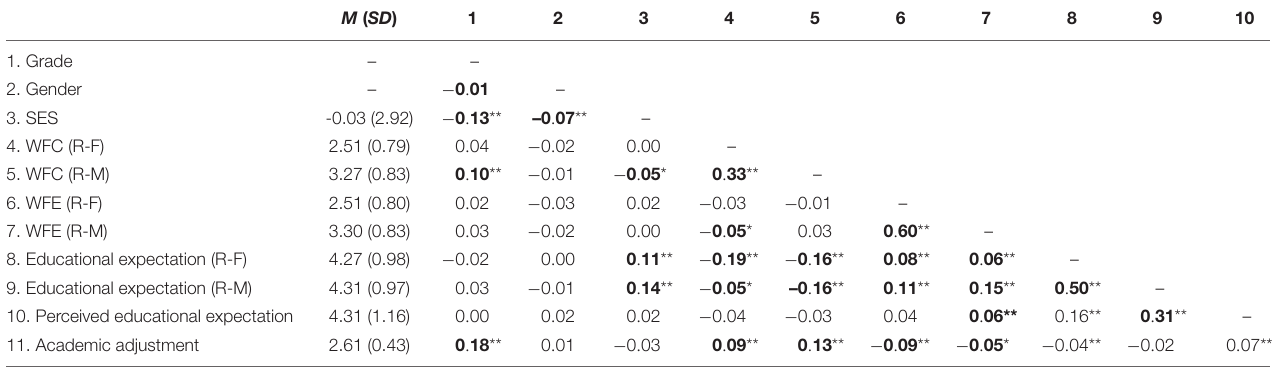
TABLE 1 | Means, standard deviations, and correlations among the study variables ( N = 2136). M ( SD ) 1 2